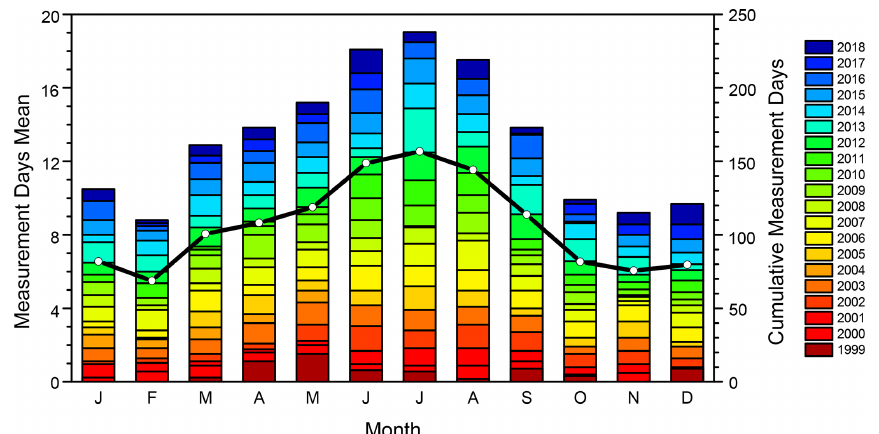
Figure 2. Monthly distribution of NDACC FTIR measurement days from 1999 to 2018. The left axis corresponds to monthly mean of measurement days over the entire period (black line), while the right axis represents cumulative measurement days per month from 1999 to 2018 (coloured